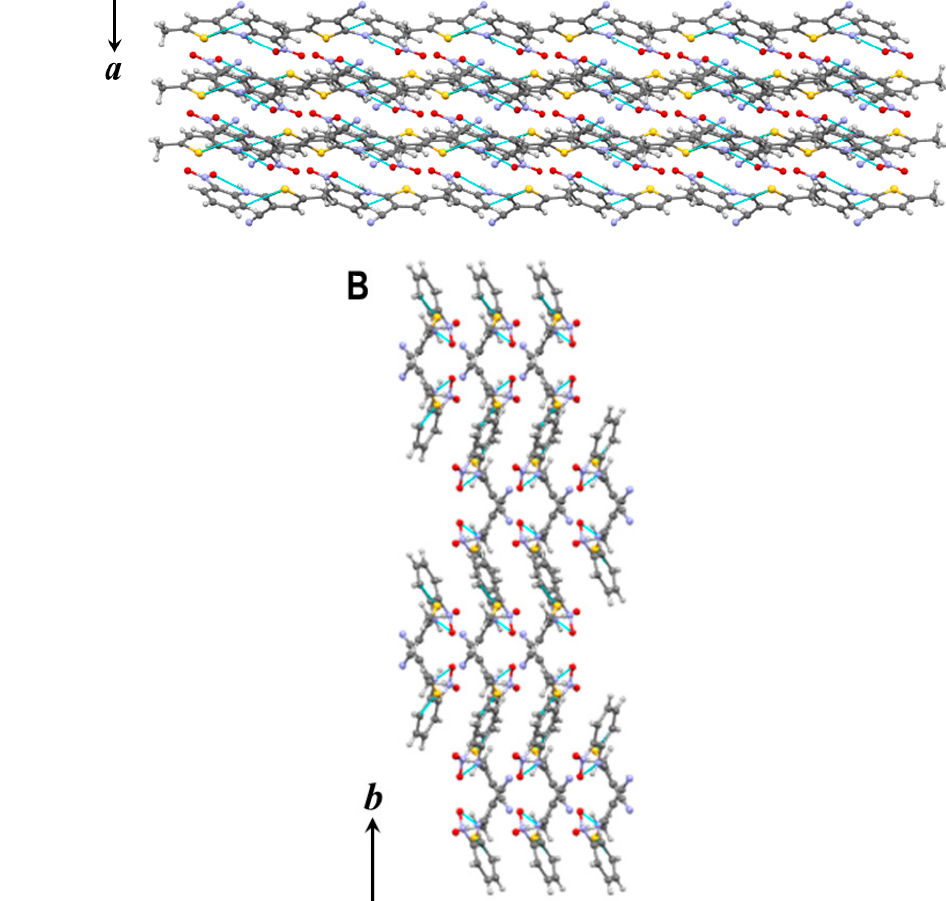
Figure 6. ( A ) Crystal packing in polymorph ON shows a layered structure along axes b and c . ( B ) The maximum expansion occurs in directions perpendicular to these layers (i.e., along axis a ), while the directions along the layers show much smaller expansivities.